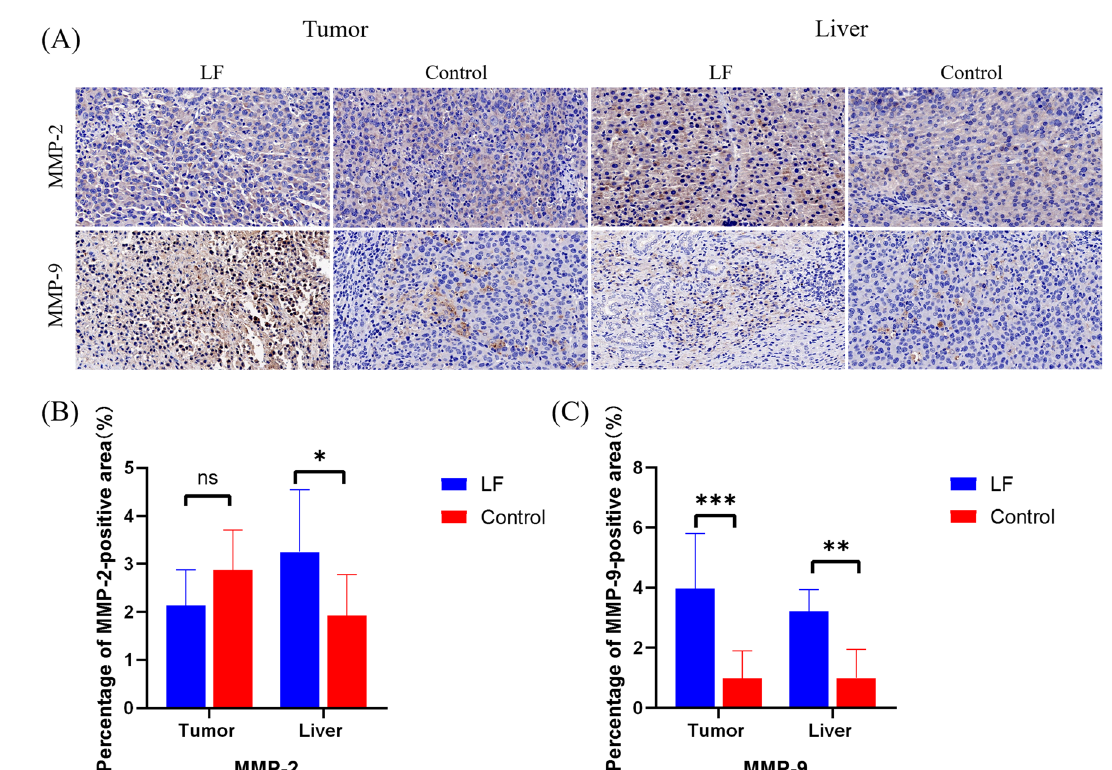
Figure 4. ( A ) Representative pictures of IHC staining of MMP-2 and MMP-9 in LF group and control group (400×); ( B ), ( C ) Quantitative analysis of immunohistochemistry results of MMP-2 and MMP-9. *P < 0.05; **P < 0.01; ***P <